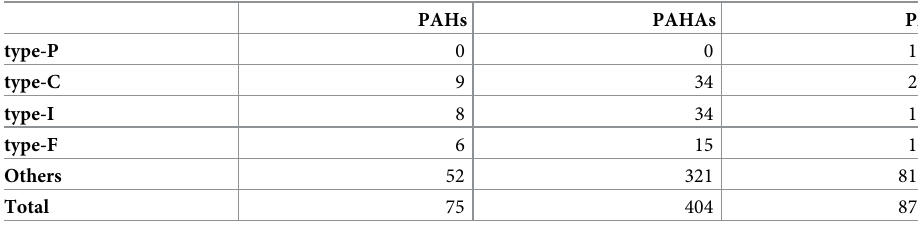
Table 1. Identification of crystals corresponding to affine transformed cubic